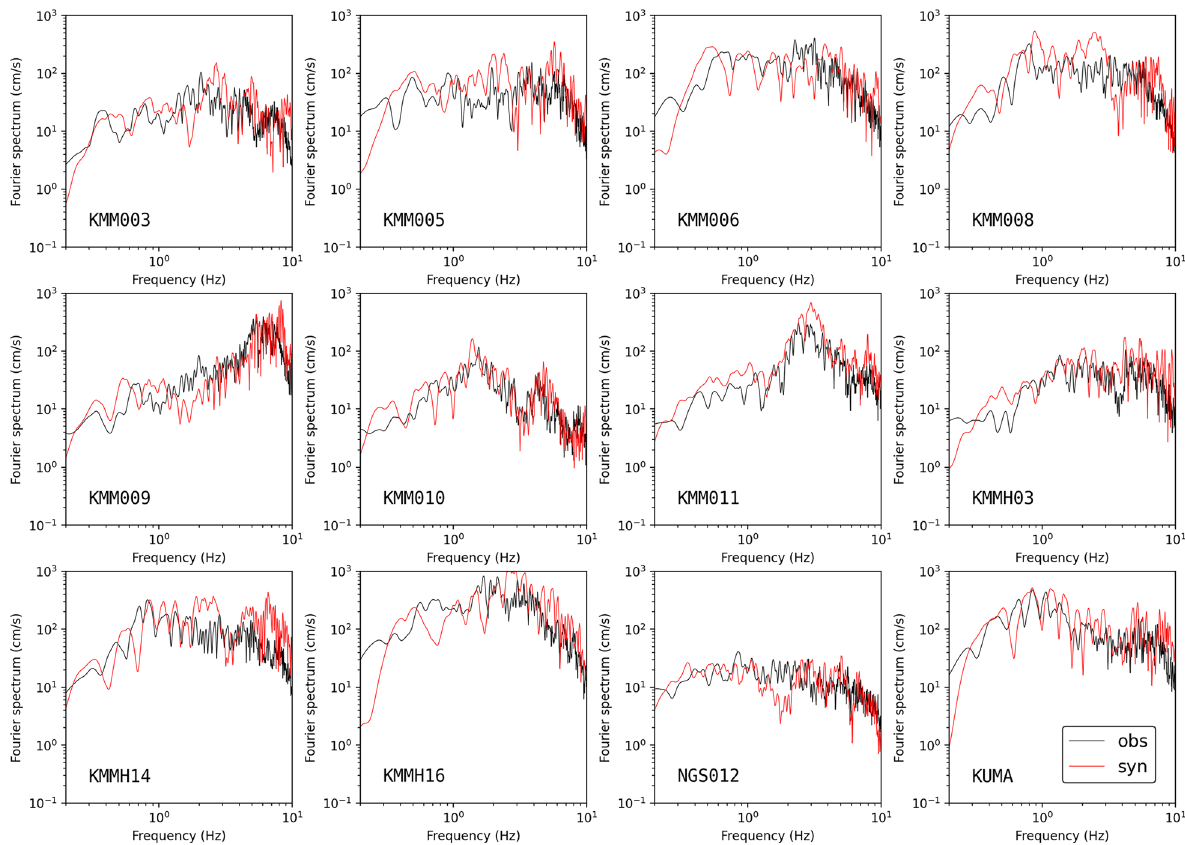
Fig. 8 Synthetic and observed Fourier spectra of the reference case for the earthquake of 2016/04/14 21:26 ( M w 6.1). Black lines indicate the observed Fourier spectra. Red lines indicate the synthetic Fourier